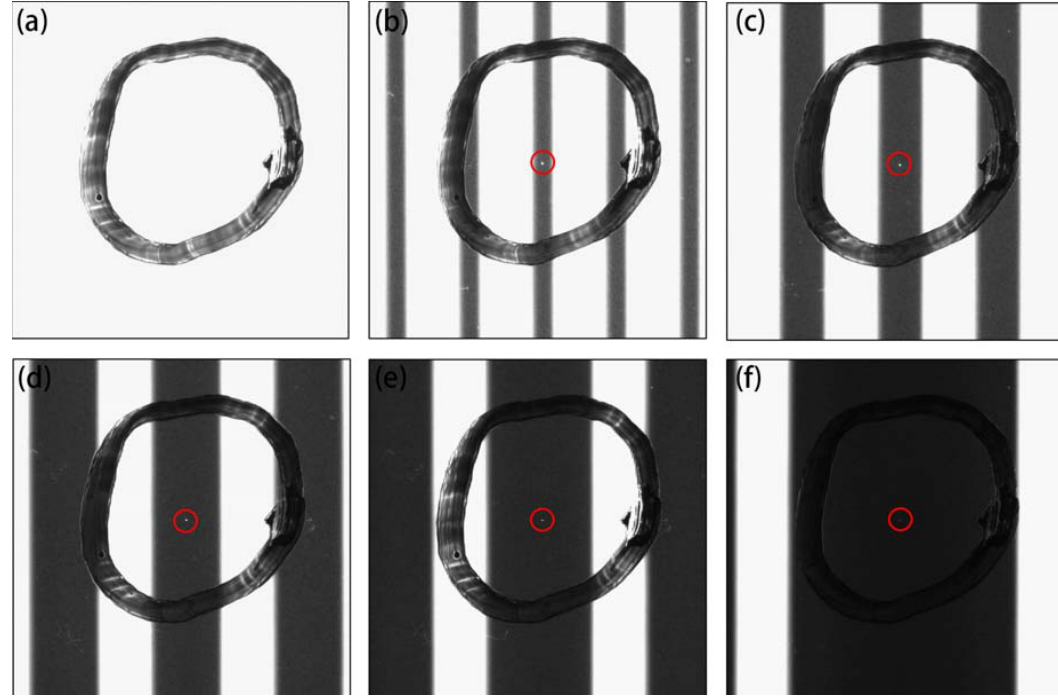
Figure 5. Indentation defect images with various stripe widths: ( a ) w12–b4; ( b ) w12–b12; ( c ) w12–b20; ( d ) w12–b28; ( e ) w12–b40; and ( f ) w12–b80. Object distance, 40 mm; image distance, 71.9 mm; camera gain, 4.25×; exposure time, 100 ms. The expression w12–b20 indicates that white and black stripe widths on the tablet PC were 12 and 20 pixels, respectively, whereas the exact sizes on the captured image were 2.10 and 1.58 mm, the width ratio of the black and white stripe was 0.75.